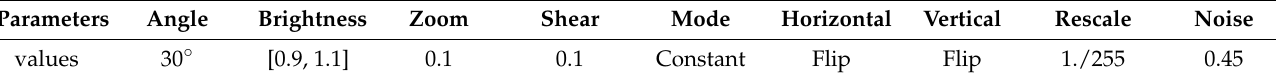
Table 3. Data augmentation techniques used to develop a Light-Dermo system.